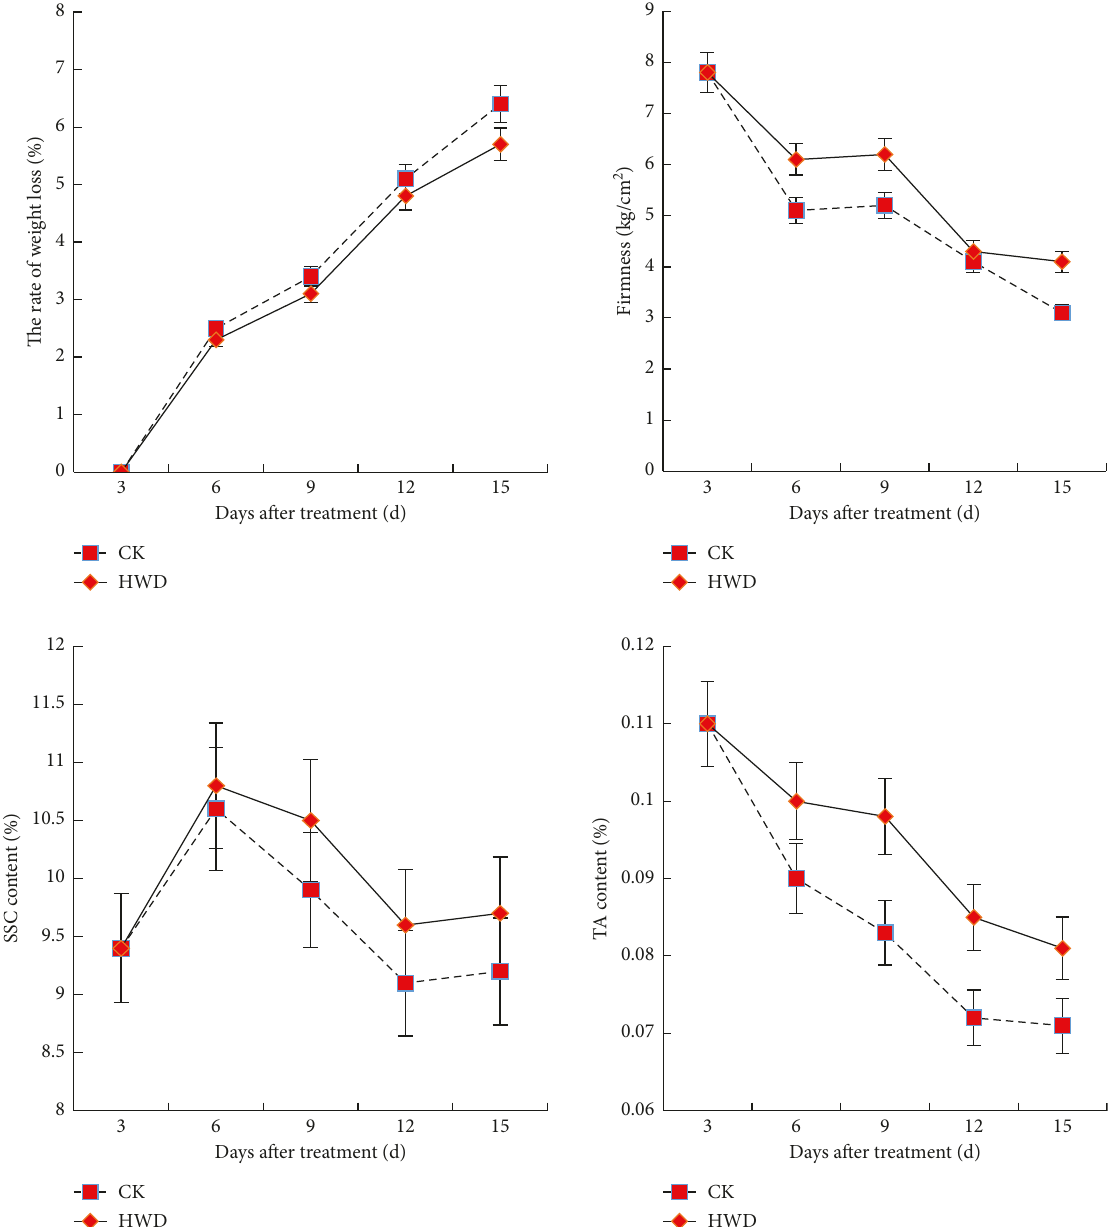
Figure 11: The effect of heat treatment on fruit weight loss rate, hardness, soluble solids, and titratable acid content. The vertical line in the figure represents the standard error ( ±